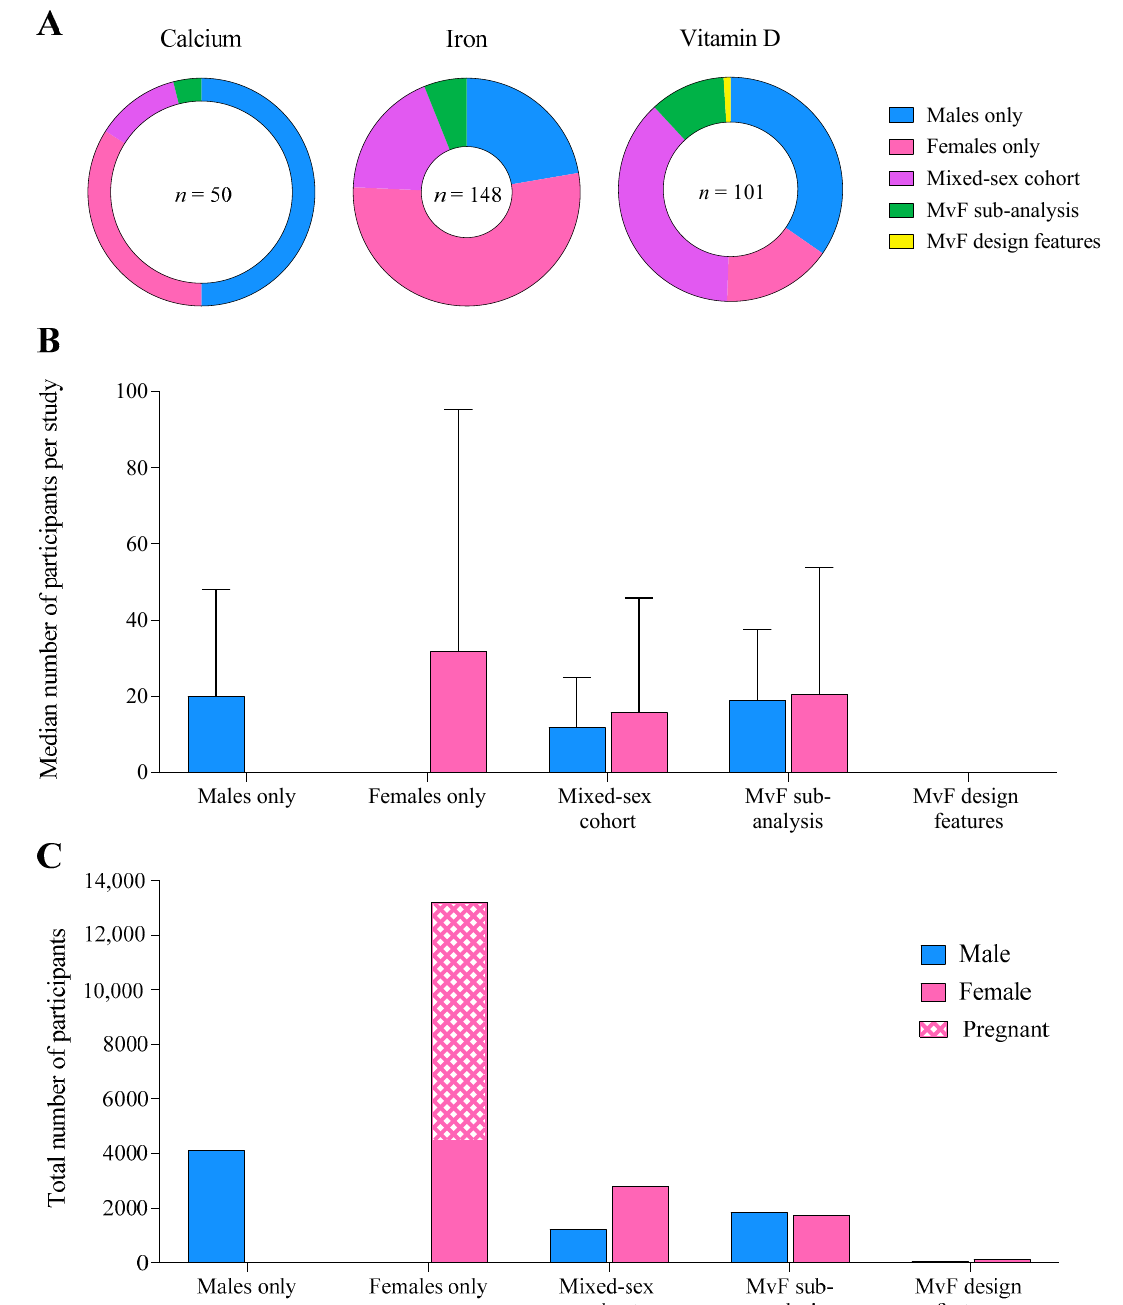
Figure 3. ( A ) The proportion of studies across each supplement published in each population, ( B ) the median number of male and female participants per study, and ( C ) total number of male, female, and pregnant participants combined across all supplements, according to the population studied.